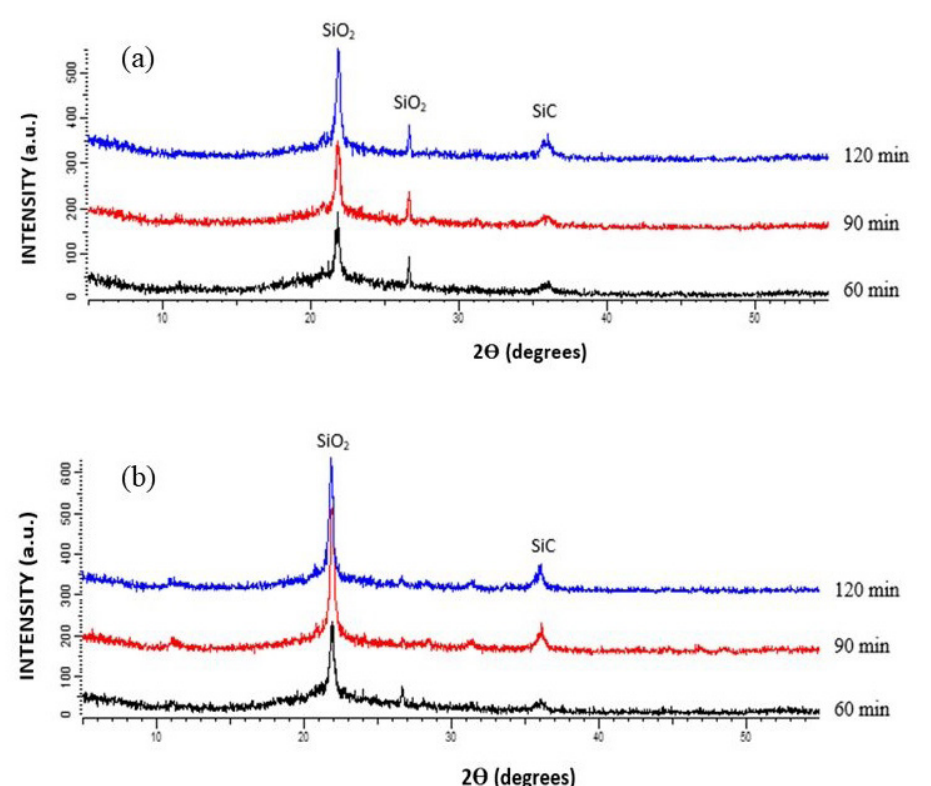
Figure 1: XRD spectra for rice husk pyrolysed at (a) 1300°C (b)